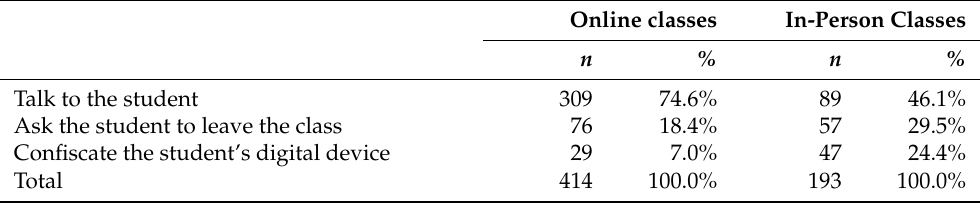
Table 13. What should a professor do to a student who disturbs the class by using a digital device?